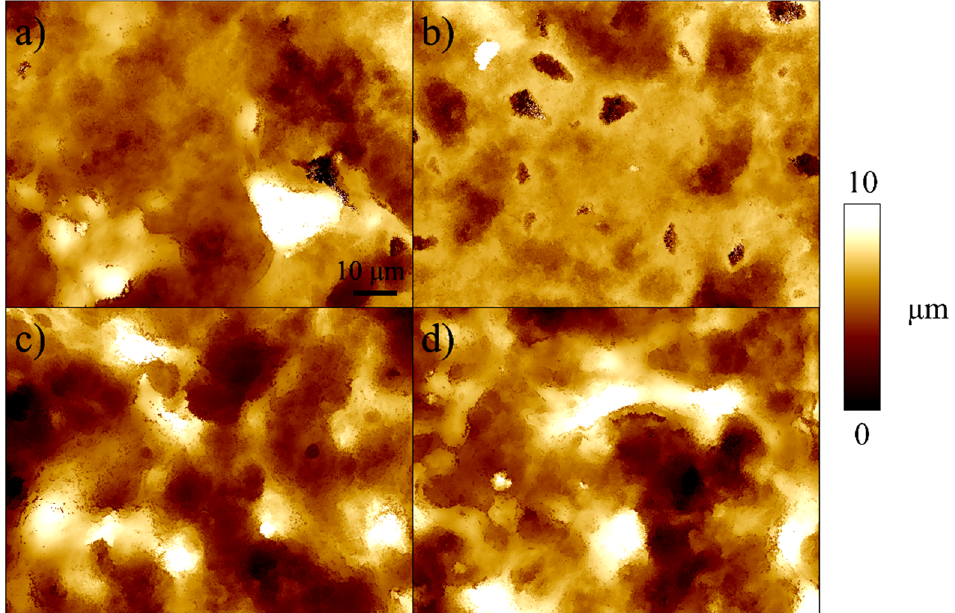
Figure 5. Images of the surface of the octacalcium phosphate substrates after in vitro testing. ( a ) octalcium phosphate, ( b ) octalcium phosphate with bisphosphonate, ( c ) octacalcium phosphate with RANKL and ( d ) octacalcium phosphate with both bisphosphonate and